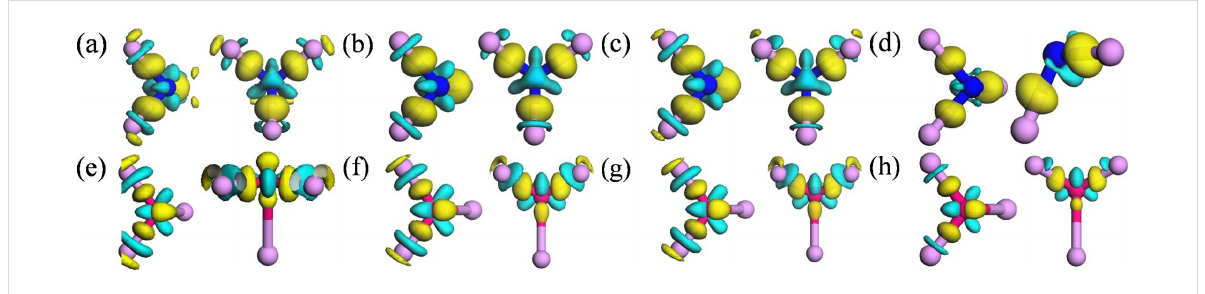
Figure 6: Charge density differences (CDDs) of doped phosphorene with different supercell sizes. (a–d) CDDs of Si-doped phosphorene with (a) 2 × 2 × 1, (b) 3 × 3 × 1, (c) 4 × 4 × 1, and (d) 5 × 5 × 1 supercell, respectively; (e–h) CDDs of S-doped phosphorene with (e) 2 × 2 × 1,